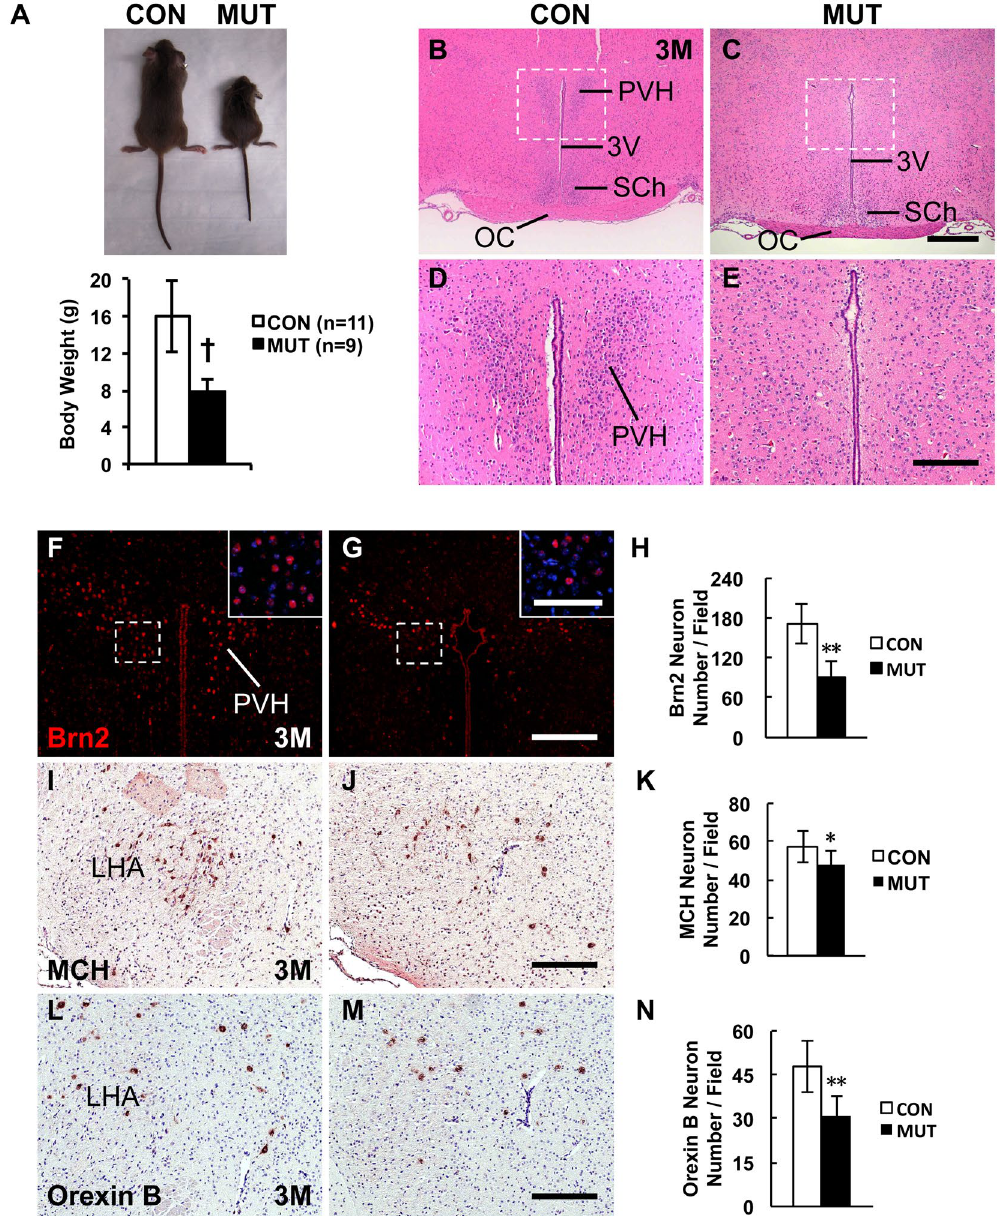
Figure 2. Adult COUP - TFII gene mutant mice with RXCre display growth retardation and compromised PVH nucleus. ( A ) Body weight of the RXCre / + ; COUP - TFII F / F male mutant mice (n = 6) is approximately half of that of the control (n = 8) at wean. The H&E staining data reveal that compared with the control ( B , D ), the PVH nucleus is barely detectable in the mutant at 3 M ( C , E ). ( D , E ) Inserts in ( B , C ). Compared with the control ( F ), there are very few Brn2 + PVH neurons in the mutant at 3 M ( G and insert), and the reduction is significant ( H and insert). Compared with the control ( I ), there are fewer MCH neurons in the mutant LHA region at 3 M ( J ), and the reduction is significant ( K ). Compared with the control ( L ), there are fewer Orexin B neurons in the mutant LHA region at 3 M ( M ), and the reduction is significant ( N ). 3 V, third ventricle; LHA, lateral hypothalamic area; OC, optic chiasm; PVH, paraventricular nucleus of hypothalamus; SCh, suprachiasmatic nucleus. The quantitative data in ( H , K and N ) were generated from the analysis of three pairs of control and mutant mice. The data indicate the mean ± SD. Student’s t-test, * P < 0.05; ** P < 0.01; † P < 0.001. Scale bars, ( B , C ) 500 μ m; ( D , E , F , G ) 200 μ m; inserts of ( F , G ) 100 μ m; ( I , J , L , M ) 100 μ